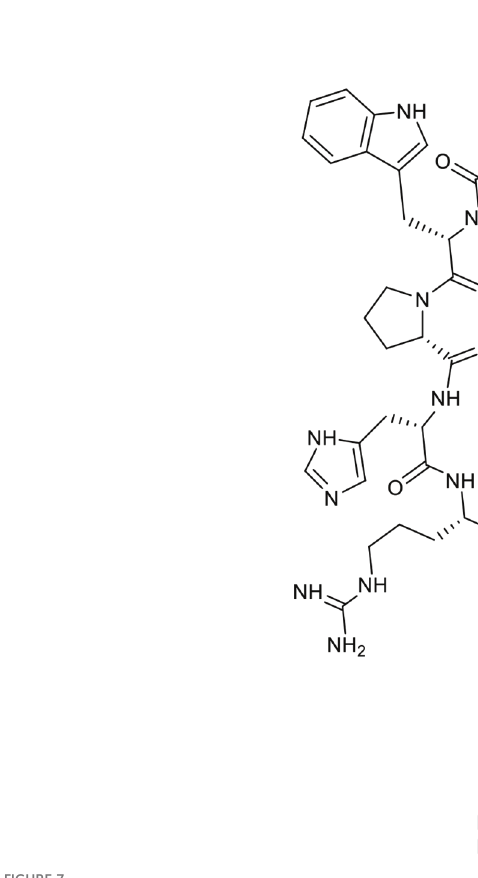
FIGURE 7 Macrocyclic peptide targeting autophagy. HL2-m5, Kd= 120 nM for LC3A and 192 nM for